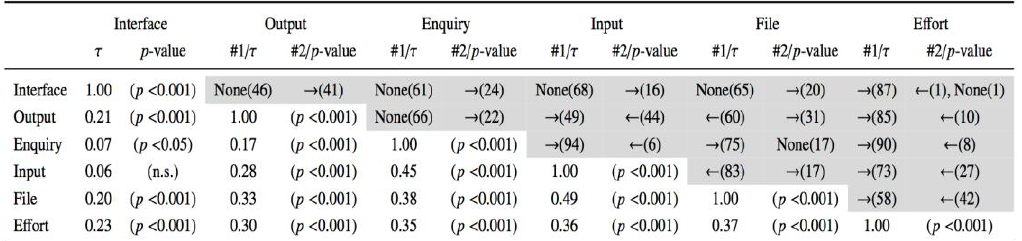
Table 4. Results of upper two causal-effect relationships (mixture: 5) and Kendall’s t and p -values for China dataset. Upper triangular indicates causal-effect relationships. Lower triangular matrix indicates